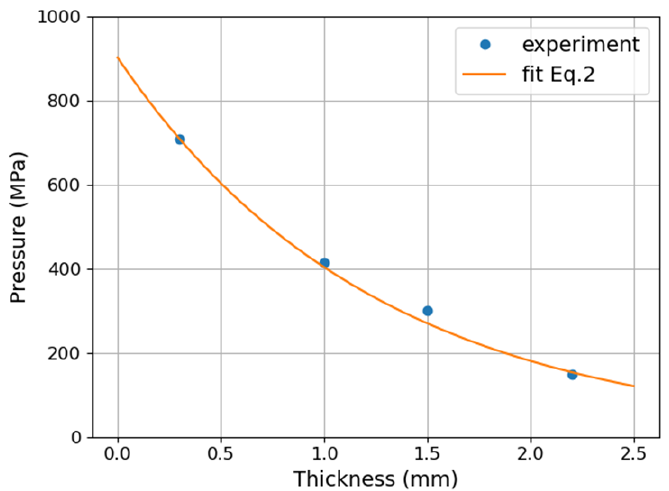
Figure 6. Pressure as a function of wave path in steel calculated from measurements made by PVDF sensors. Points—experimental values, Line—fitted function from Equation (2).